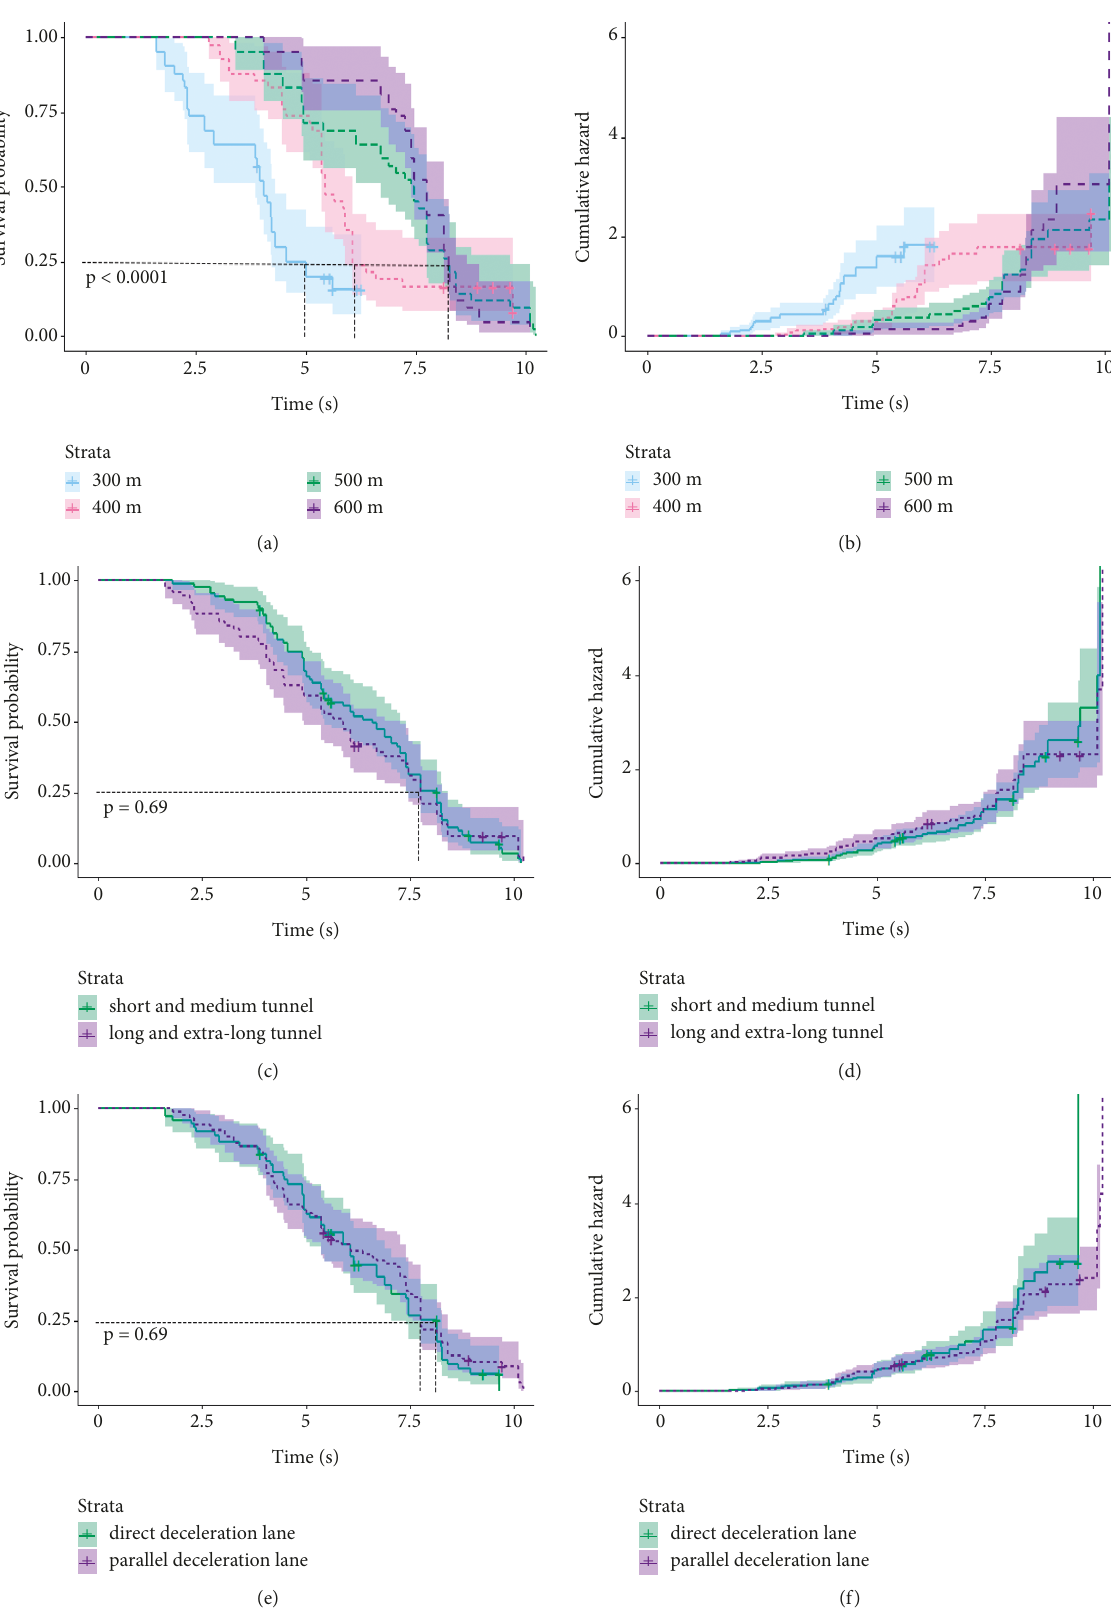
Figure 9: Distribution characteristics of MLCD under road factors. (a) Cumulative survival function curve of spacing. (b) Cumulative hazard function curve of spacing. (c) Cumulative survival function curve of tunnel types. (d) Cumulative hazard function curve of tunnel types. (e) Cumulative survival function curve of deceleration types. (f) Cumulative hazard function curve of deceleration